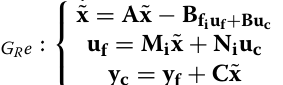
u f and y f respectively. The main objective of RC is to hide actuator fault from the controller and stabilize the sys- tem output. The dynamic equation describing the internal dynamics of the RC is given in